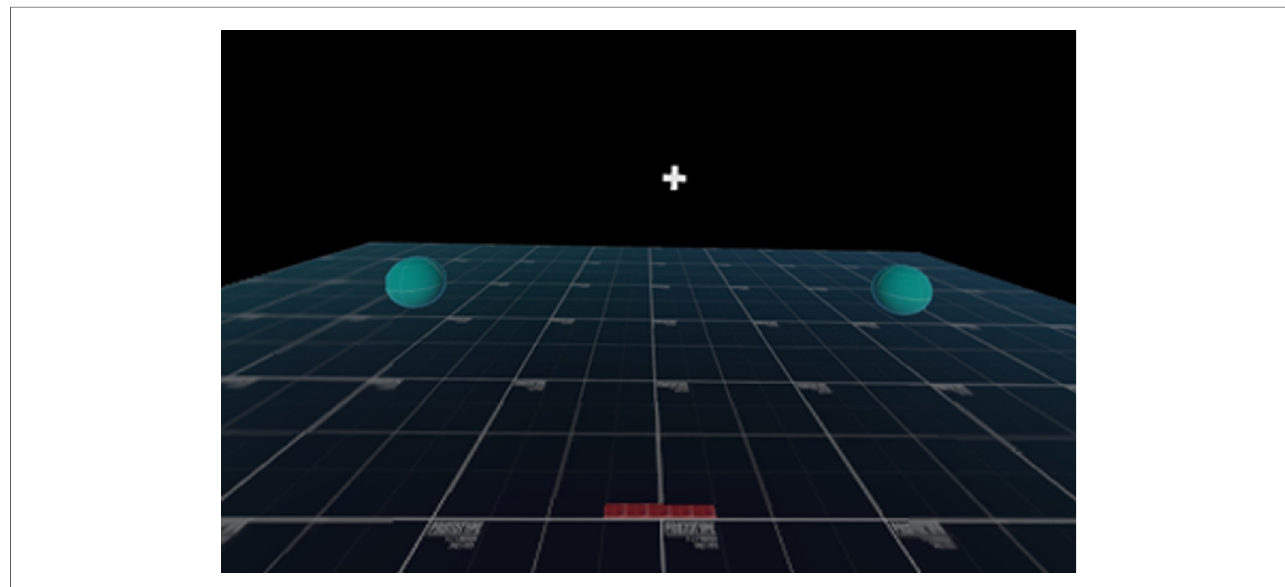
FIGURE 1 Virtual reality head-mounted display view depicting green response target spheres prior to T-pose calibration procedure. Throughout 40-trial test, response targets located beyond peripheral fi eld of view with head in neutral position (i.e., neck rotation to left or right required to locate correct response target).